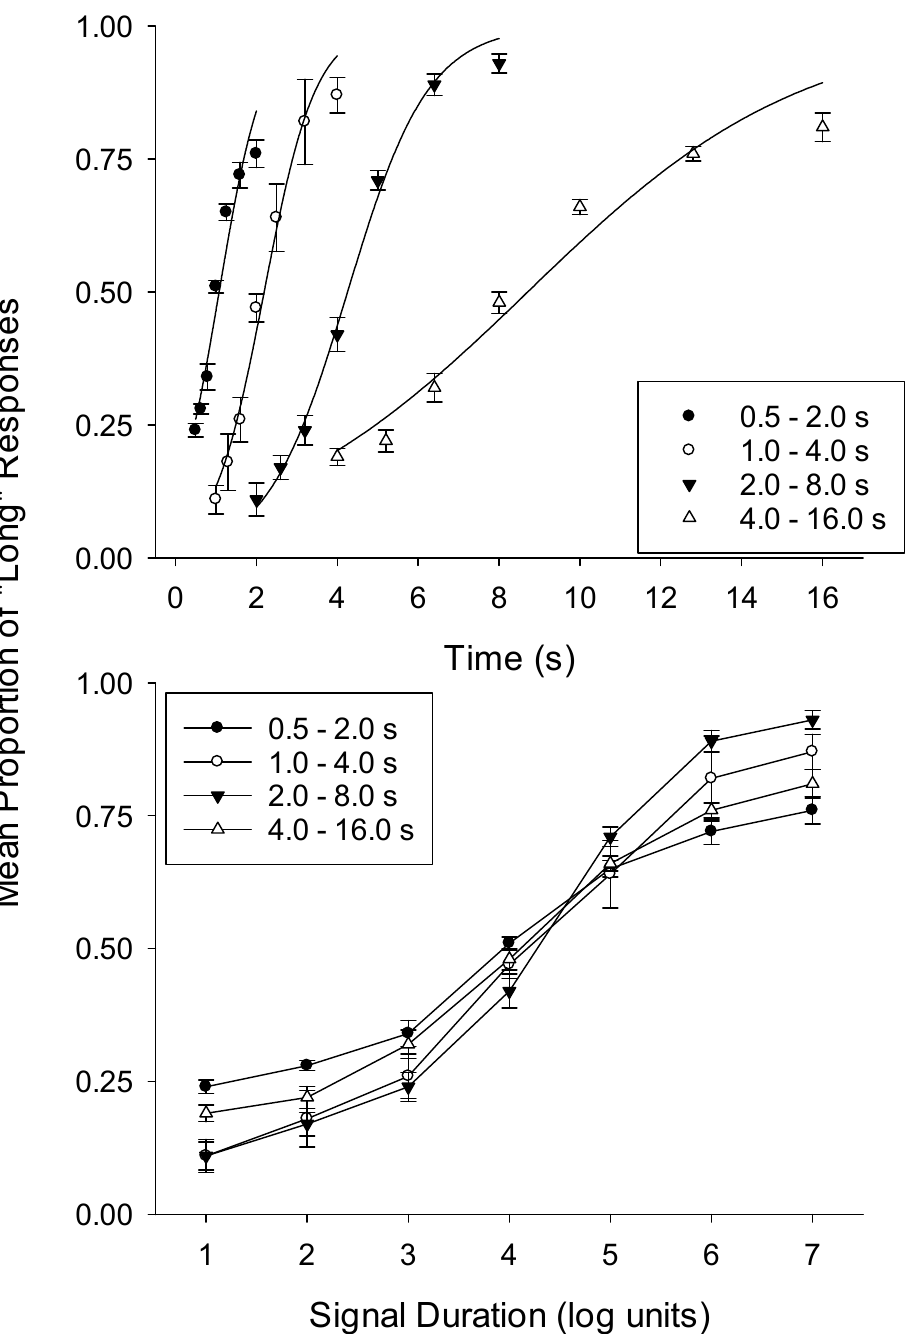
Figure 1. The top panel shows the proportion of “Long” responses plotted as a function of signal duration (s). The smooth lines through the data points were fit by Equation 1. The bottom panel shows the proportion of long responses as a function of time (top panel), as a function of signal duration in logarithmic units (bottom panel). The four duration ranges used were 0.5–2.0, 1.0–4.0, 2.0–8.0 and 4.0–16.0 s. The error bars are the standard error of the mean.